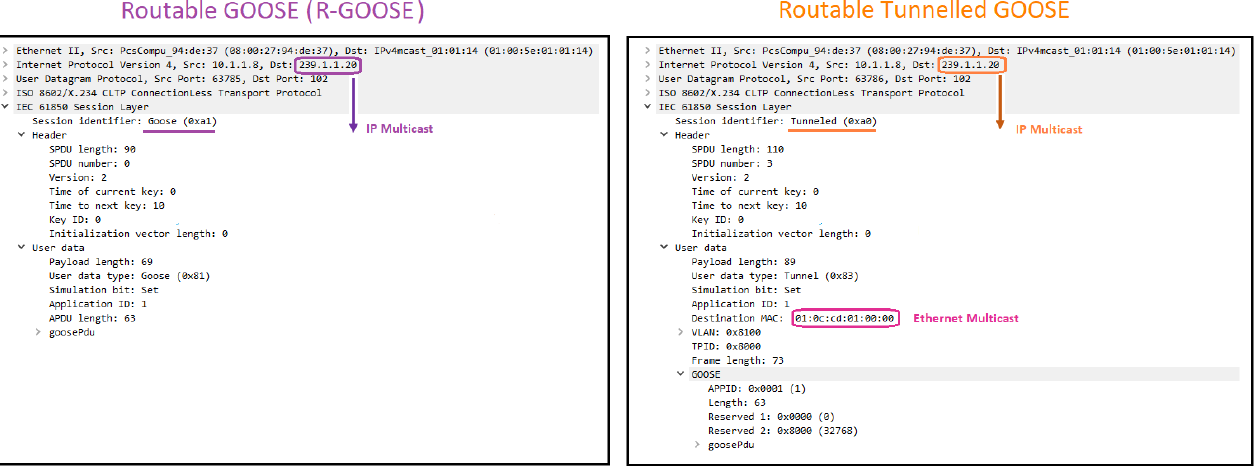
Figure 3. Multicast communication of Routable-Tunneled SV/GOOSE from Substation 1 to Substation 2 and 3.